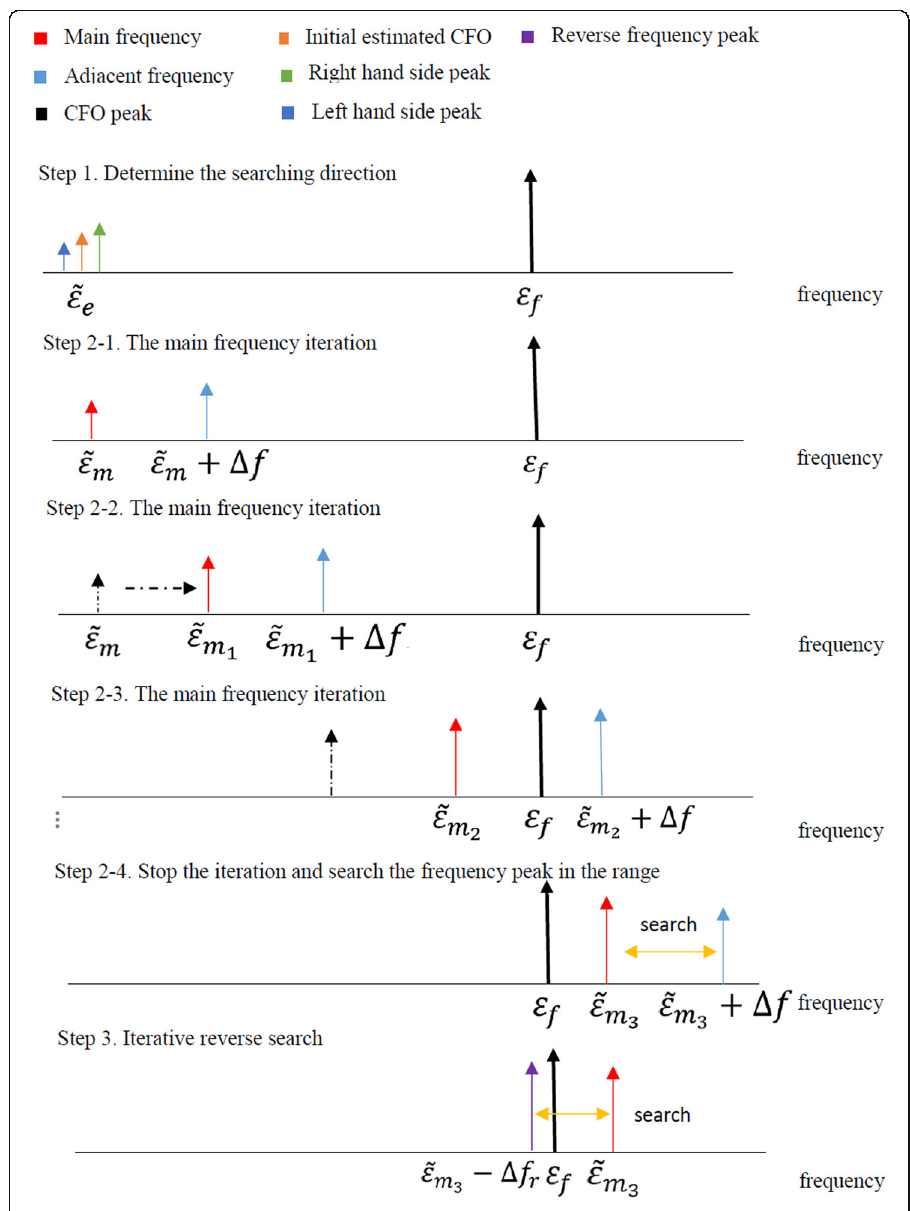
Fig. 5 Reverse iterative searching